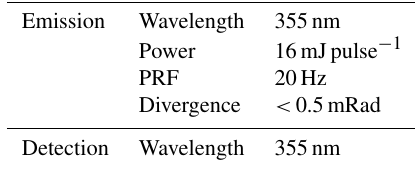
Table 1. Main characteristics of Leosphere